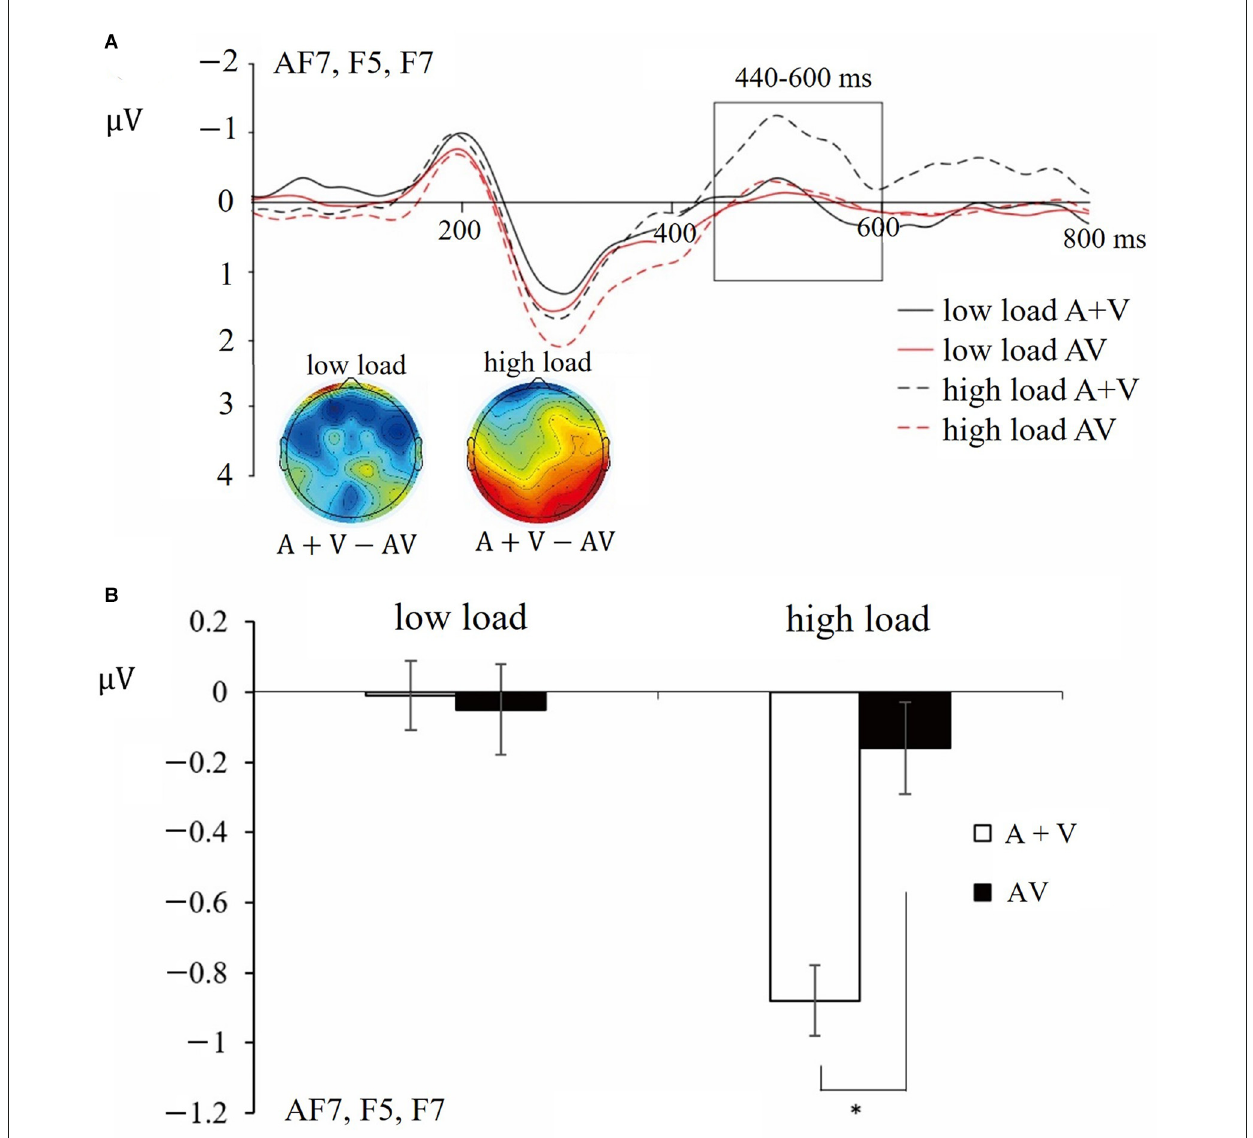
FIGURE5 (A) Grand-average distractor-synchronized ERP waveforms at each experimental condition. Time window of 440–600 ms is highlighted in the box (electrodes AF7, F5, F7). Time zero on the x-axis corresponds to the distractor stimulus onset. (B) Mean amplitudes and standard errors for